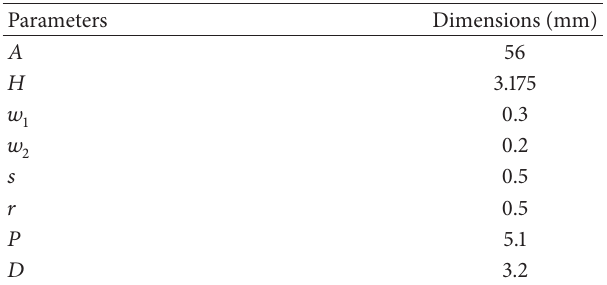
Table 1: Design parameters for optimum antenna performance